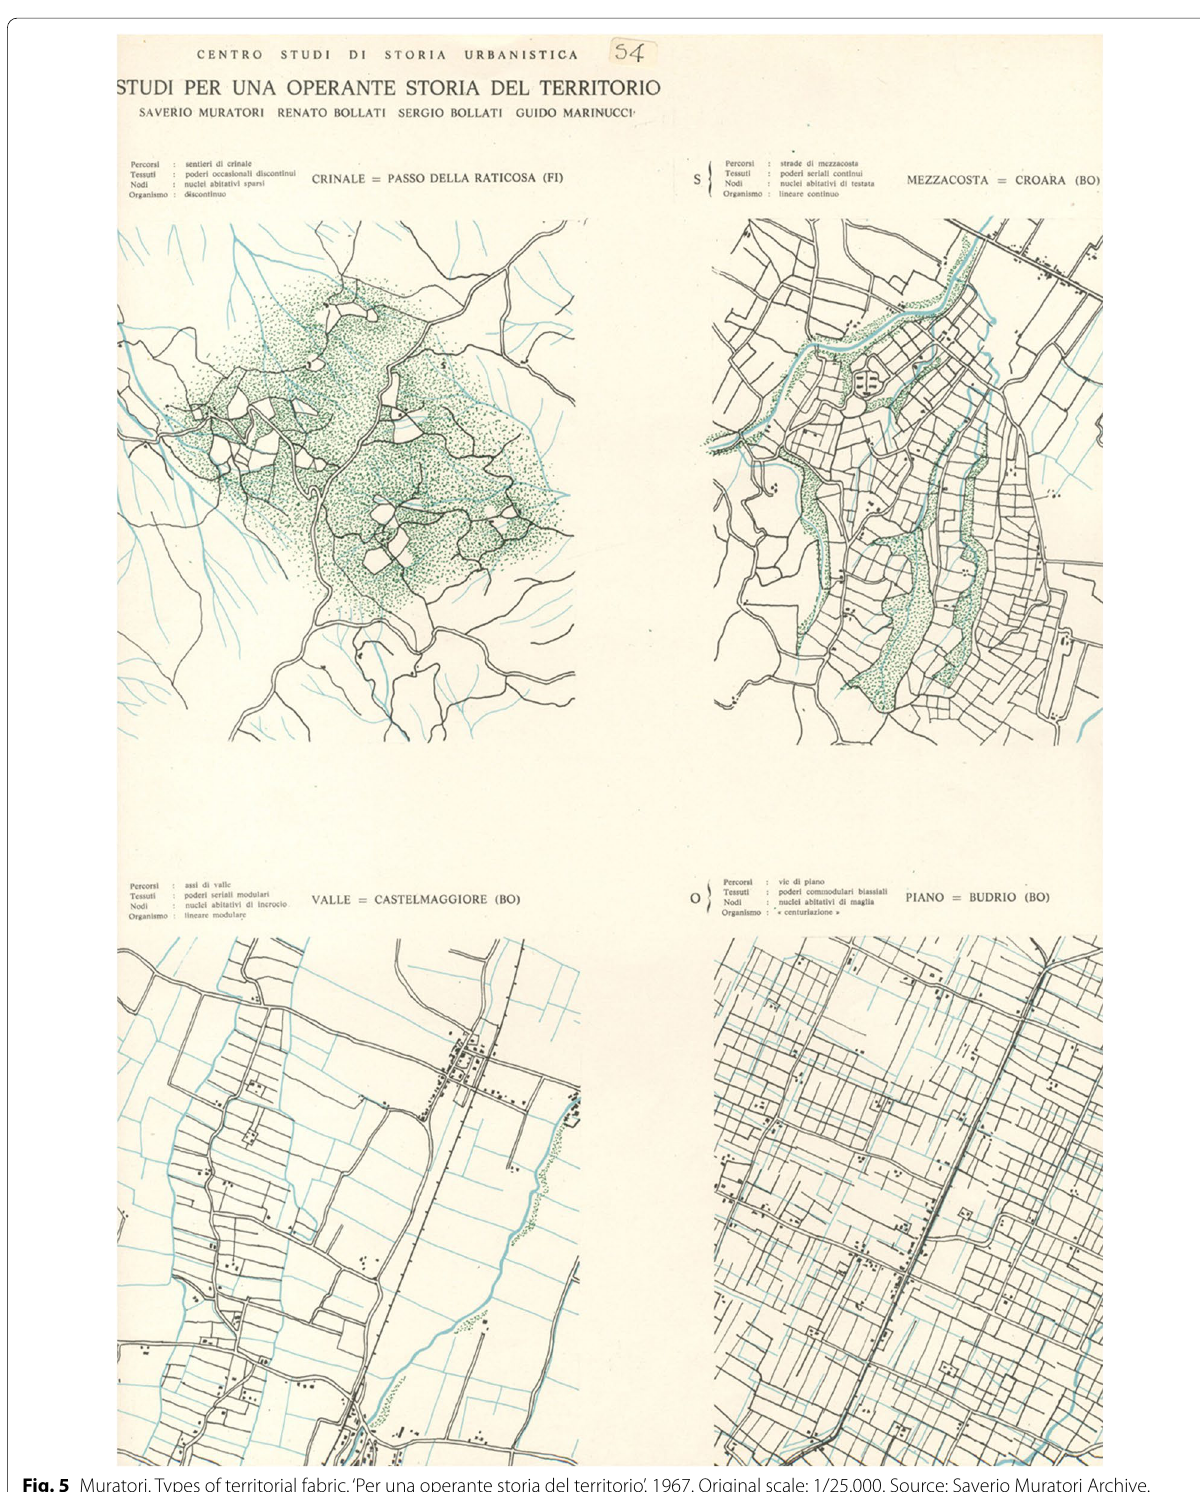
Fig. 5 Muratori. Types of territorial fabric. ‘Per una operante storia del territorio’. 1967. Original scale: 1/25.000. Source: Saverio Muratori Archive. Biblioteca Civica d’Arte Luigi